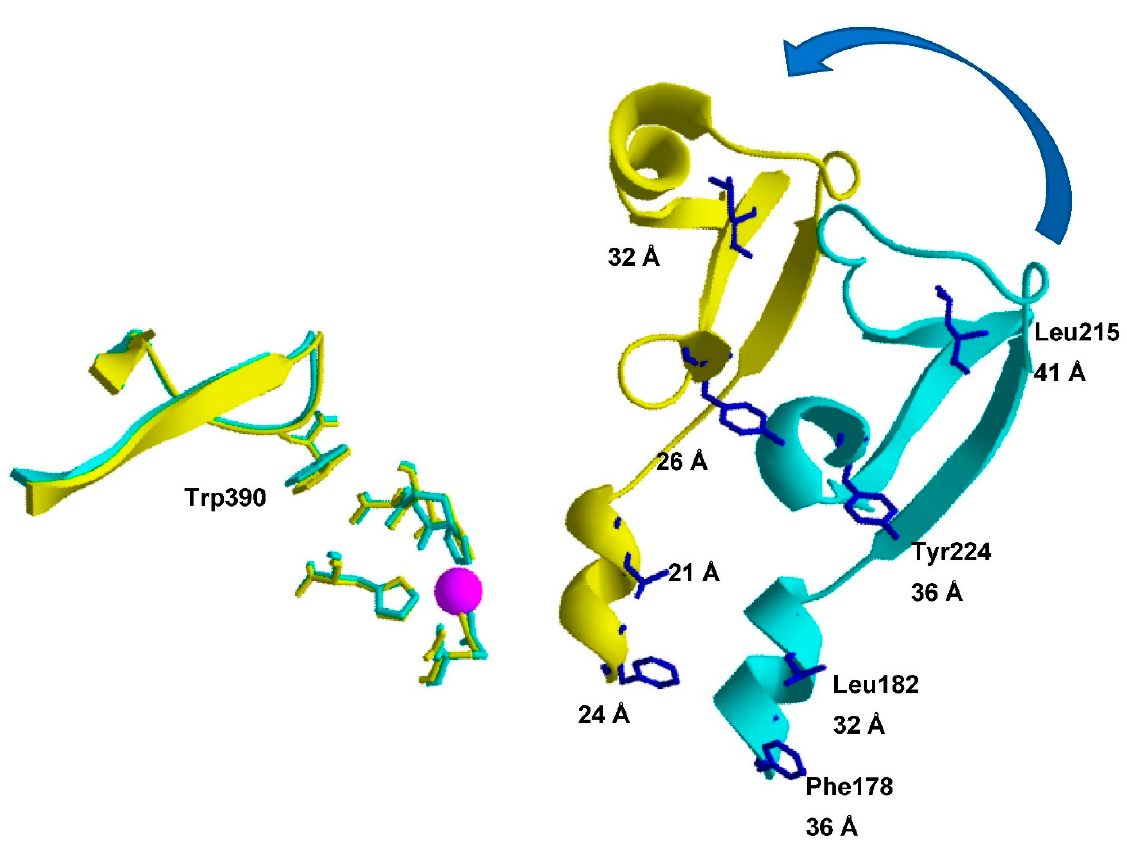
Figure 2. Positions of the D-A pairs (Trp390 and p NF residues) in the TOP structure. The Figure is a representation of a part of the overlay of the open and closed TOP molecules, fixing the zinc binding site HExxH + E + Zn 2+ (pink sphere), shown in Figure 1C. The arrow highlights the relative change in position of domains D(onor) and A(cceptor) that should occur considering the hinge-like closing of TOP. Positions of the Trp390 residue (donor) and the fluorescence acceptor probe ( p NF) are given together with the corresponding D-A distances. Figure was made by using Swiss pdb Viewer v.4.1.0 [42].